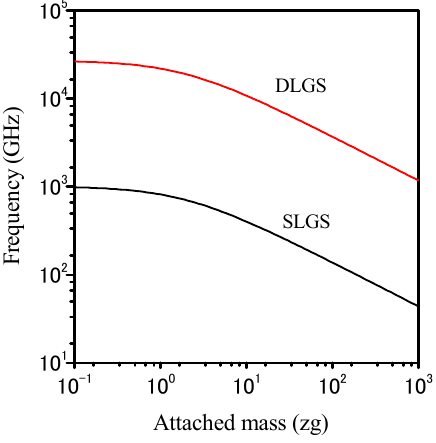
Figure 4. Comparison of the resonant frequency variation for DLGSs- and SLGSs-based mass sensors ( (cid:1838) 2ℎ = (cid:1838) 2ℎ = 20, (cid:2022) = (cid:2015) = 0.5⁄⁄ ). (cid:3028) (cid:3029)